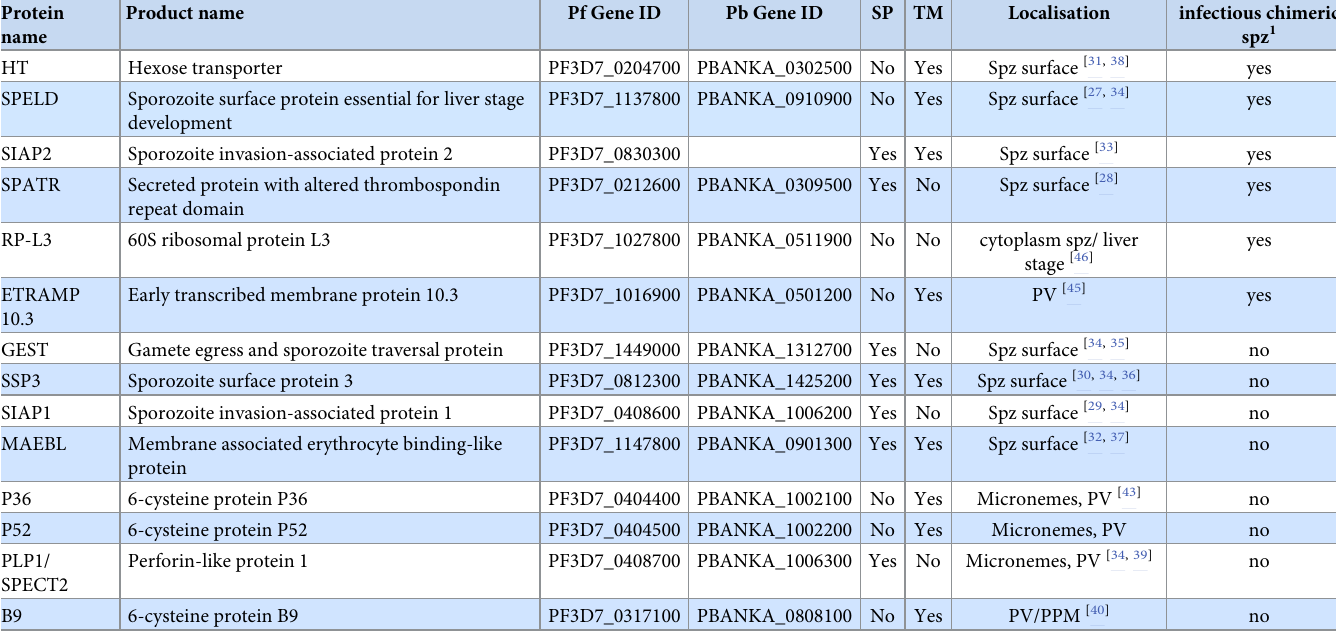
Table 1. Selected pre-erythrocytic P . falciparum